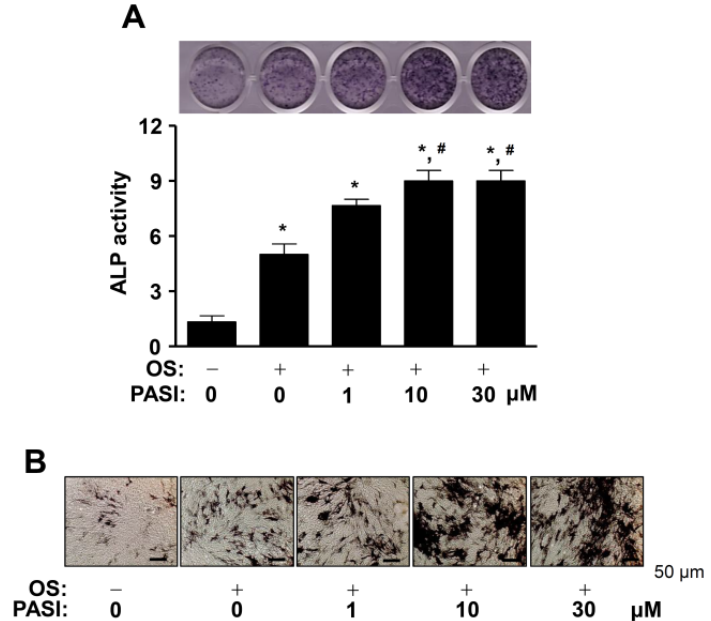
Figure 3. Effects of PASI on the staining and activity of ALP during early osteoblast differentiation. ( A ) The staining of ALP was visualized using a scanner ( upper ). The activity of ALP was analyzed by using a spectrophotometer and exhibited as a bar graph ( bottom ). ( B ) ALP-positive cells were detected under light microscopy. Data are expressed as the mean ± S.E.M. of experiments. * p < 0.05, # p < 0.05 indicate a statistically significant difference compared to the control and OS, re- spectively.